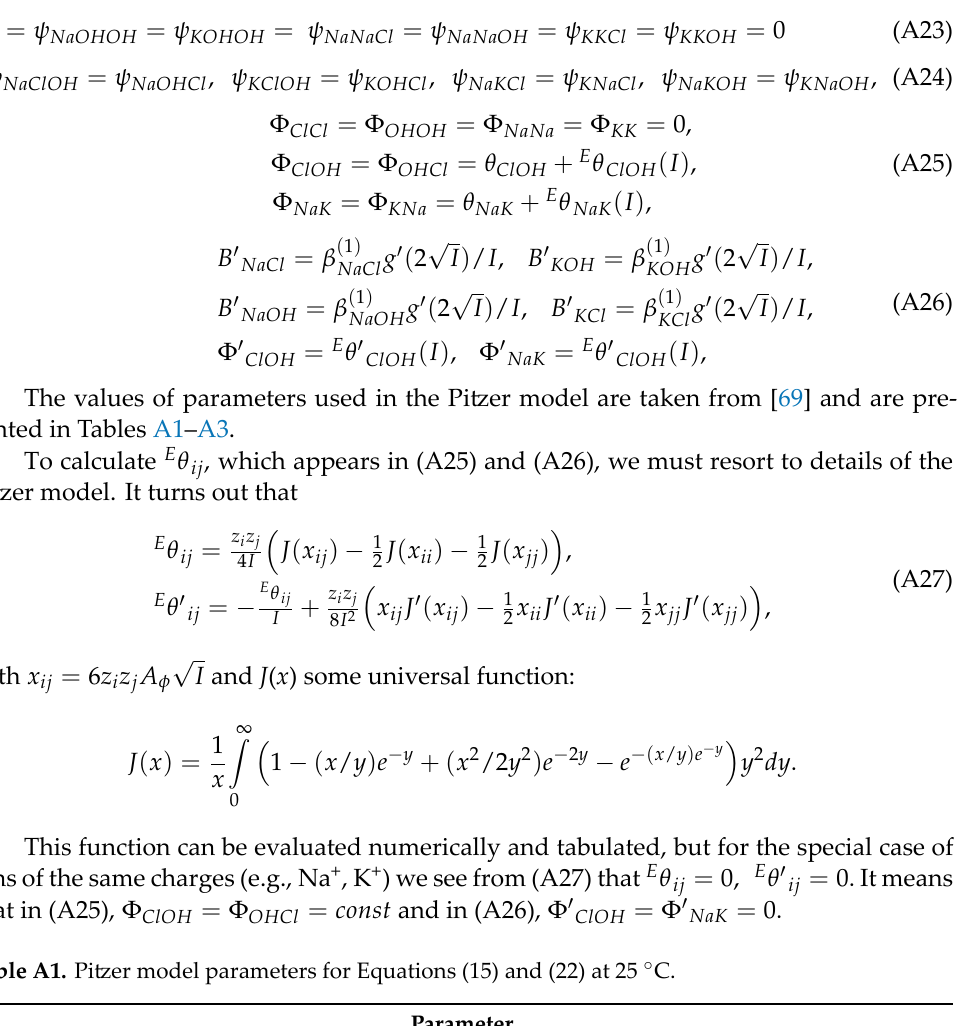
Table A1. Pitzer model parameters for Equations (15) and (22) at 25